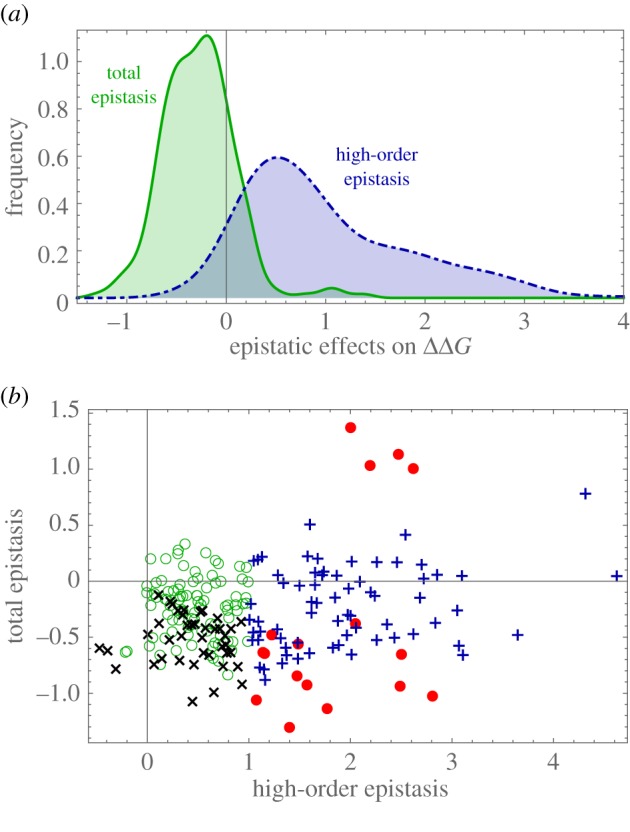
(a) Histograms of total and high-order structural epistasis in the ancestors. Solid green line, total epistasis (same as figure 7a, shown for reference); dot-dashed blue line, high-order epistasis (mean = 1.024 kcal mol−1; variance = 0.77). (b) High-order versus total structural epistasis. Green rings, no epistasis; red bullets, total and high-order epistasis; black cross symbols, total epistasis but no high-order epistasis; blue plus symbols, no total epistasis but with high-order epistasis. Results from FoldX dataset.